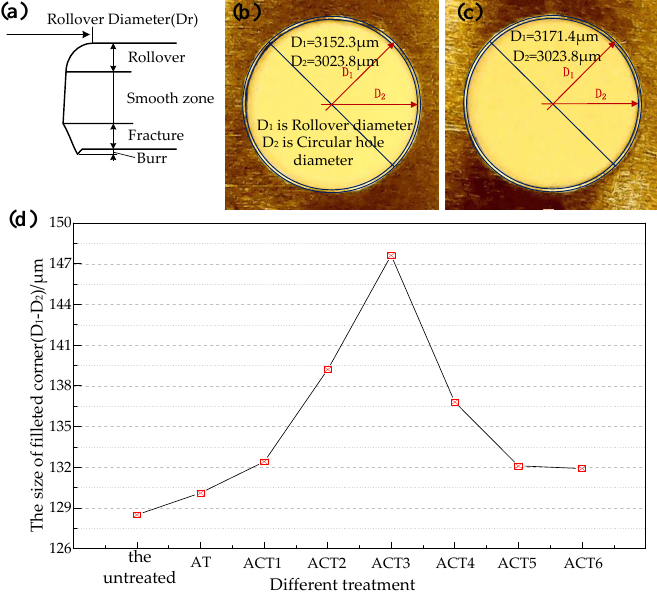
Figure 10. Rollover diameter of the specimens: ( a ) untreated; ( b , c ) example of measured results; and ( d ) changes in rollover diameters.